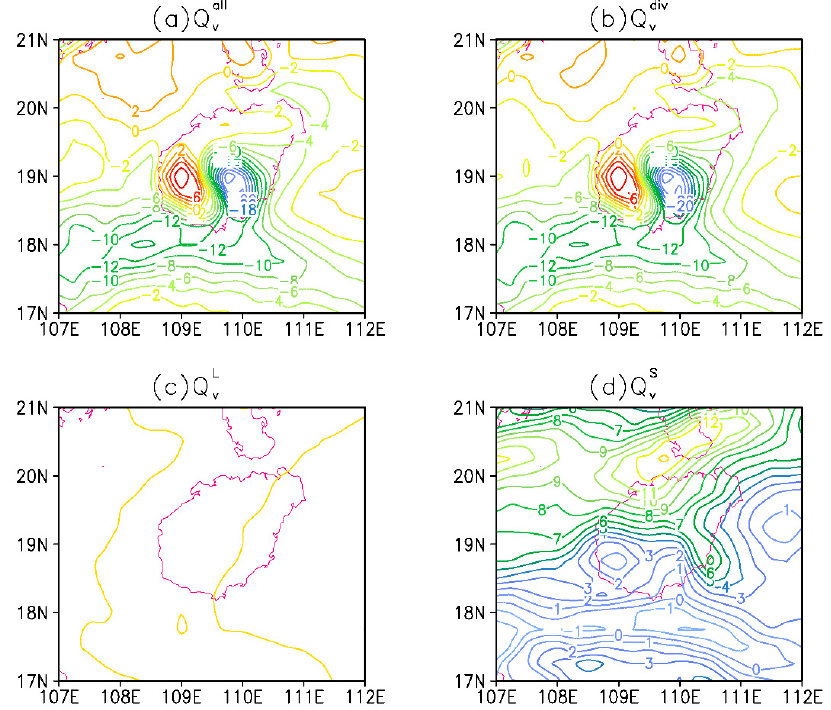
Figure 8. ( a ) Q vall , ( b ) Q vdiv , ( c ) Q vL (shaded, units: 10 − 7 g · hPa − 1 · cm − 2 · s − 1 ), and ( d ) Q vS (shaded, units: 10 − 8 g · hPa − 1 · cm − 2 · s − 1 ) at 925 hPa averaged over the later stage.